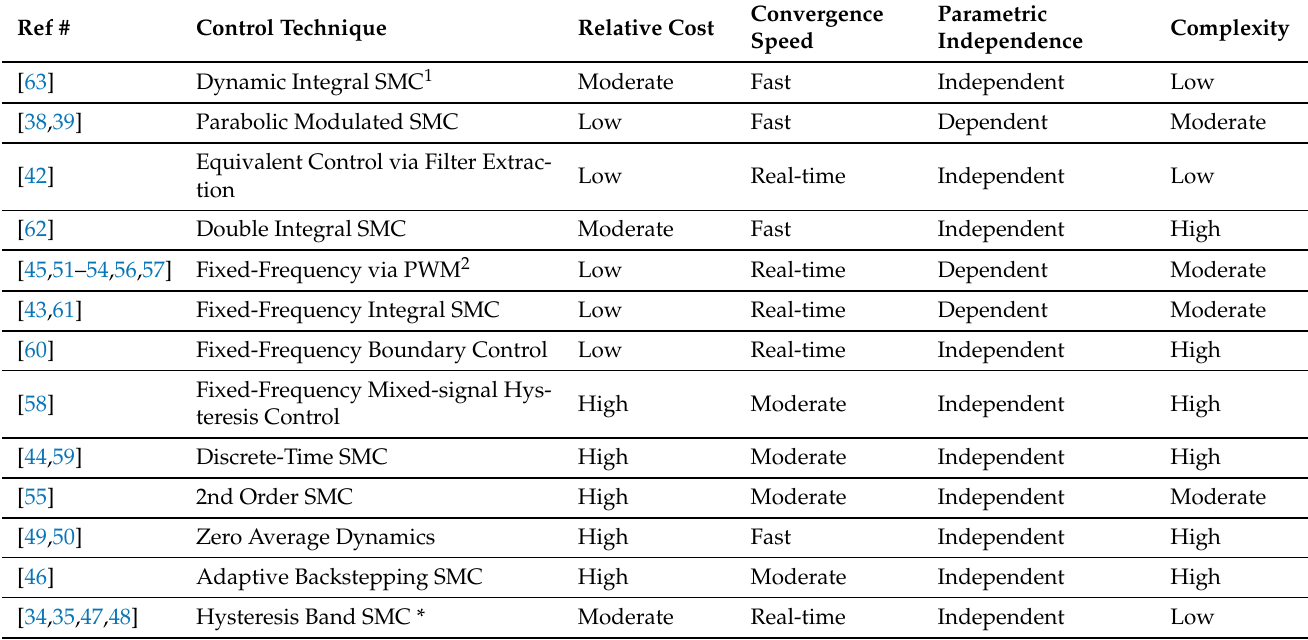
Table 1. Converter control techniques